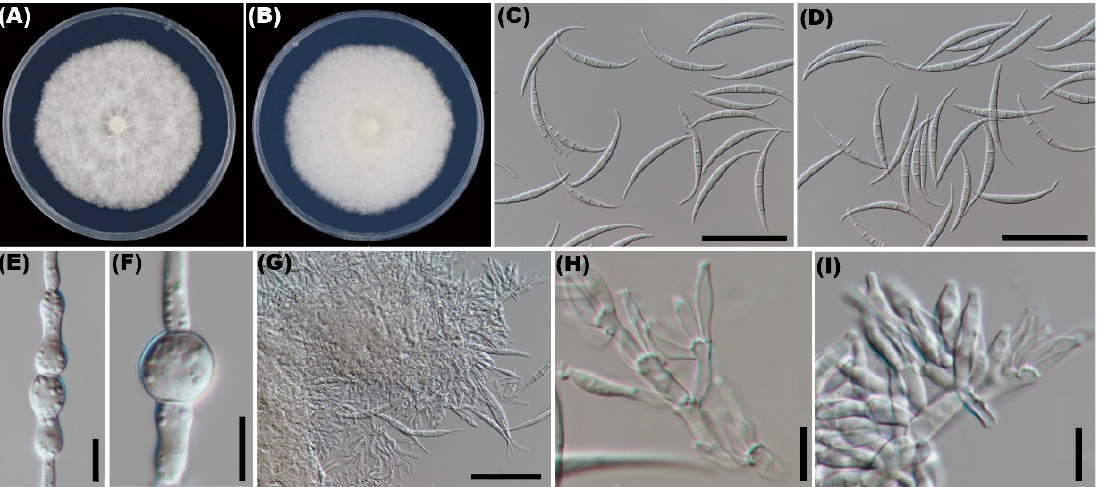
Figure 2. ( A , B ) Colony on PDA after incubation for 7 days. ( C , D ) Macroconidia. ( E , F ) Chlamydospores. ( G – I ) Conidiogenous cells form on sporodochia. Bars: ( C , D , G ) = 50 μ m; ( E , F , H , I ) = 10 μ m.